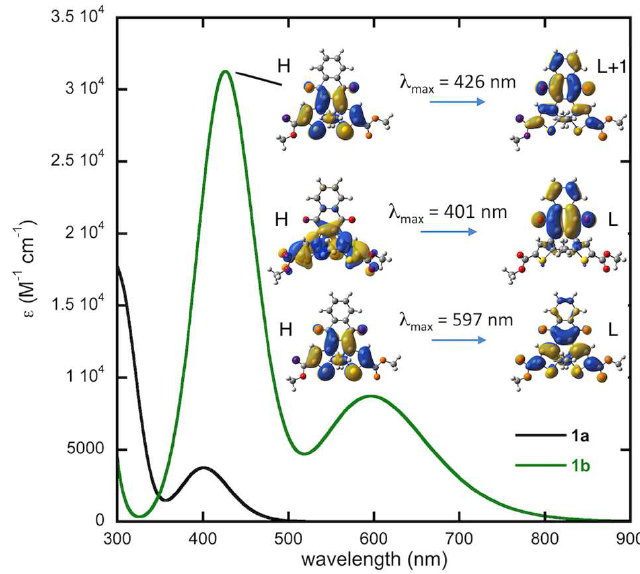
Figure 7. Computed spectrum of 1a and 1b in dichloromethane at time-dependent density functional theory (TD–DFT) level and molecular orbitals (H: HOMO, L: LUMO, isocontour: 0.02) involved in the main electronic transitions.